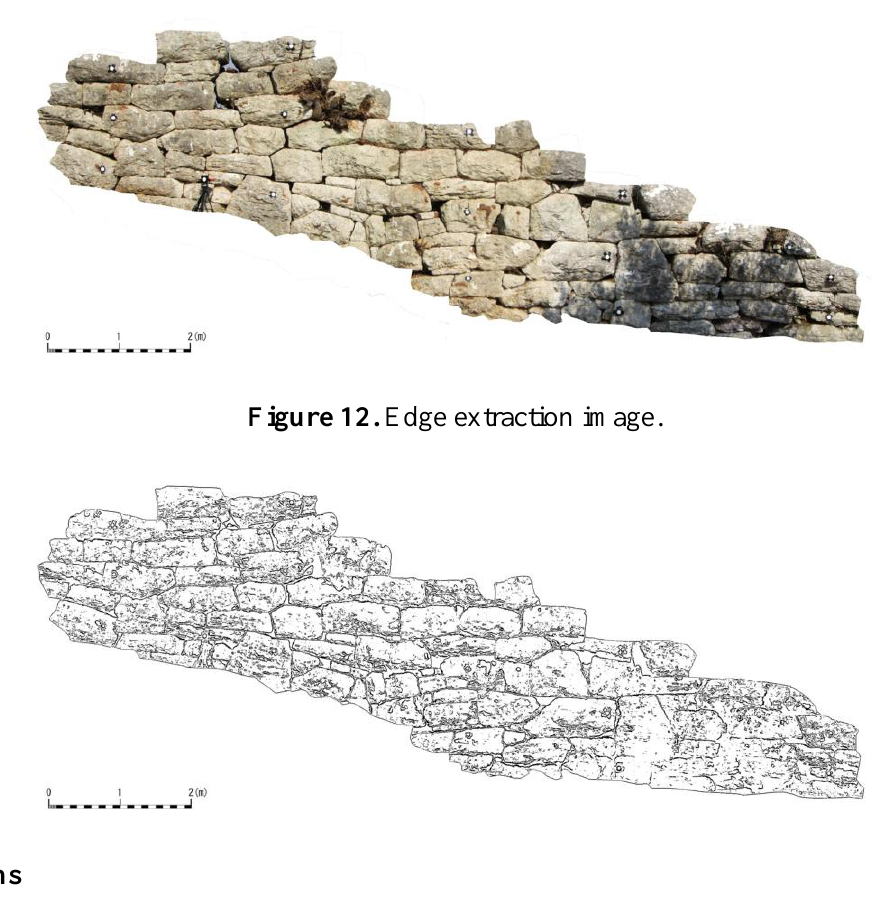
Figure 11. Ortho image of city wall.